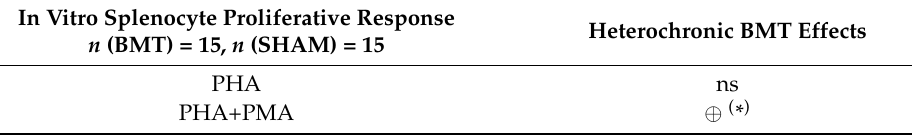
Table 7. In vitro splenocyte proliferative response (cell source: spleen). In Vitro Splenocyte Proliferative Response